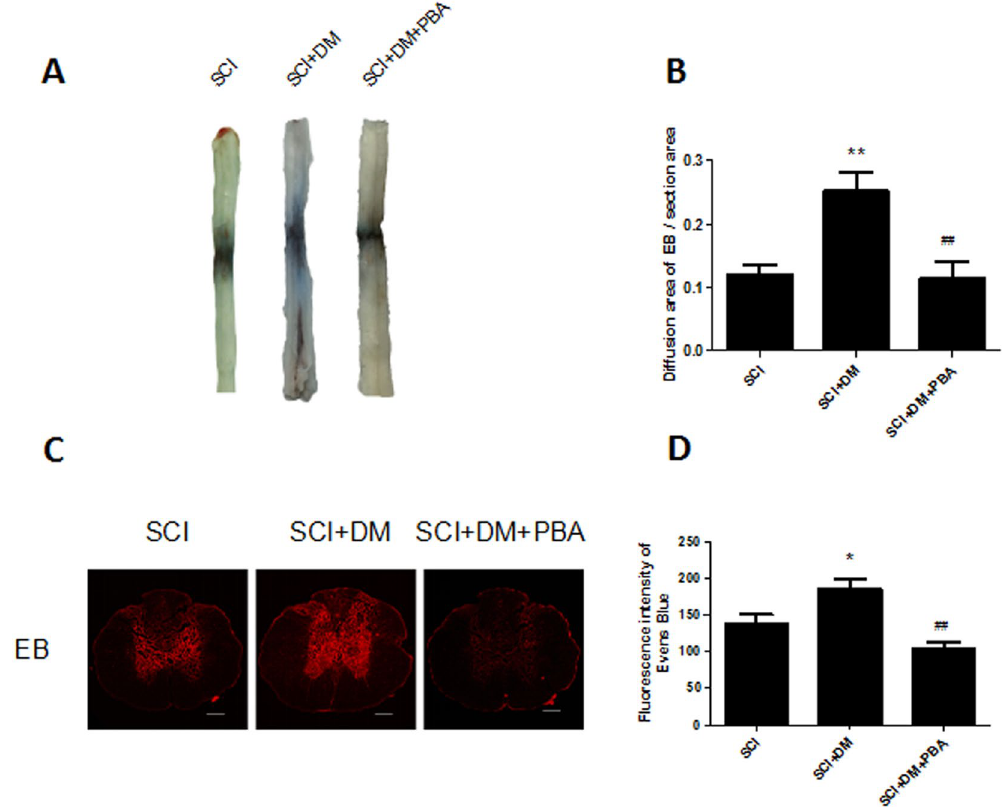
Figure 6. Inhibiting ER stress attenuates the adverse effects of diabetes in BSCB disruption after SCI. After SCI, barrier permeability was measured 1d after injury, using EB dye in SCI, SCI + DM and SCI + DM + PBA group. ( A , B ) Representative whole spinal cords and quantification of BSCB permeability data in each group showing EB dye permeabilized into the spinal cord, n = 4. ( C , D ) Representative confocal images of EB extravasation and quantification of the fluorescence intensity of EB in each group, n = 4. Scale bar = 1 mm. * p < 0.05, ** p < 0.01 vs SCI group, ## p < 0.01 vs SCI + DM